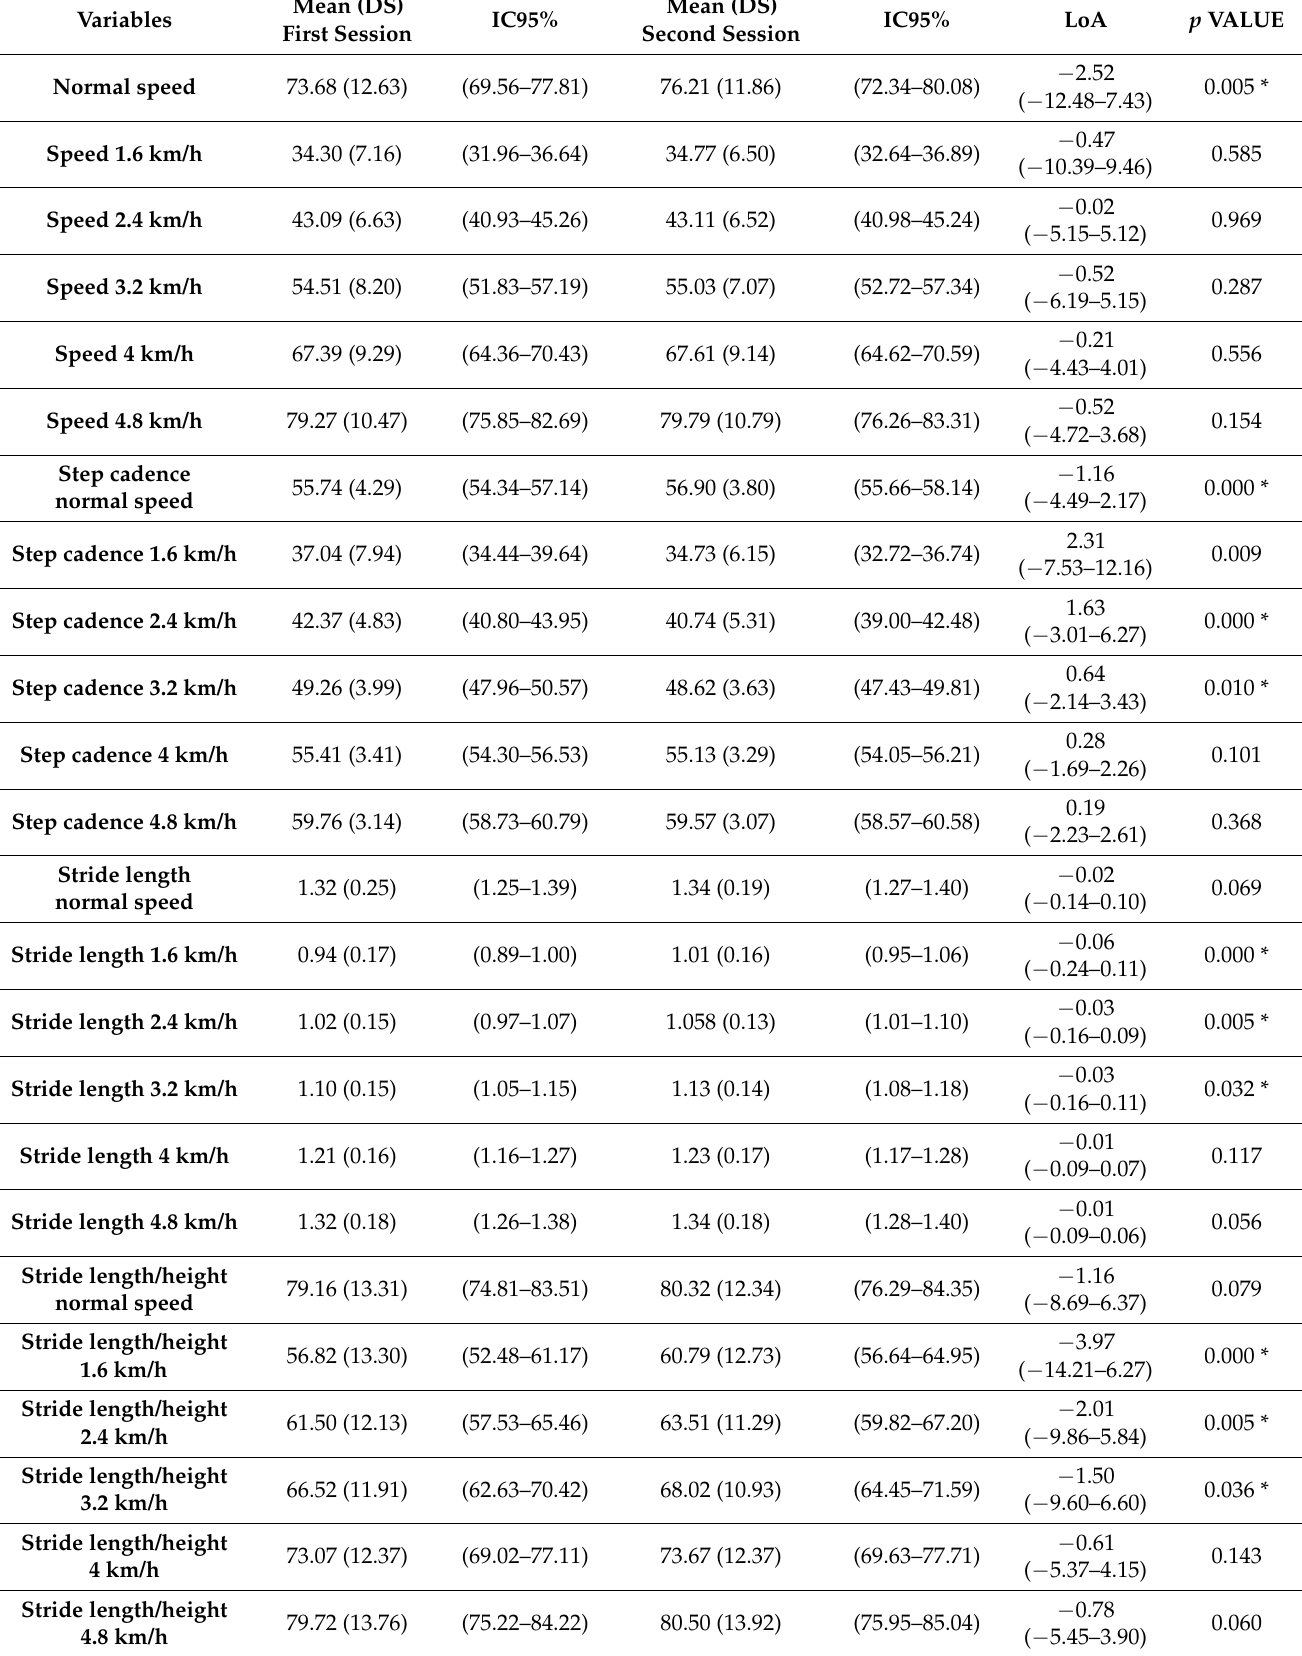
Table 4. Systematic differences between the first and second